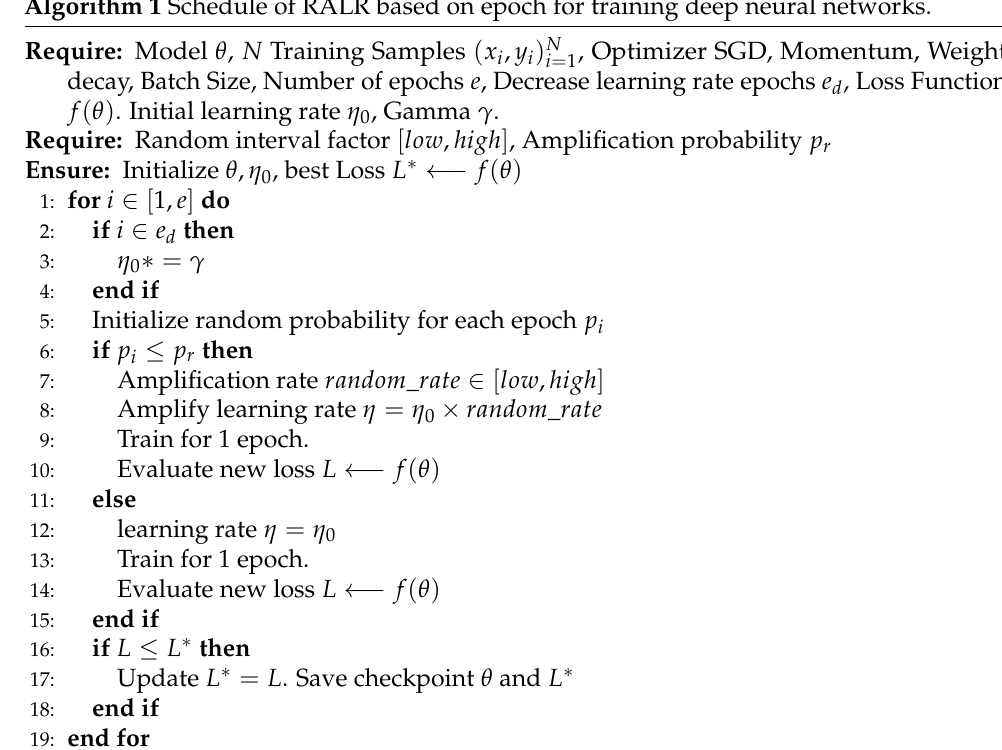
Algorithm 1 Schedule of RALR based on epoch for training deep neural